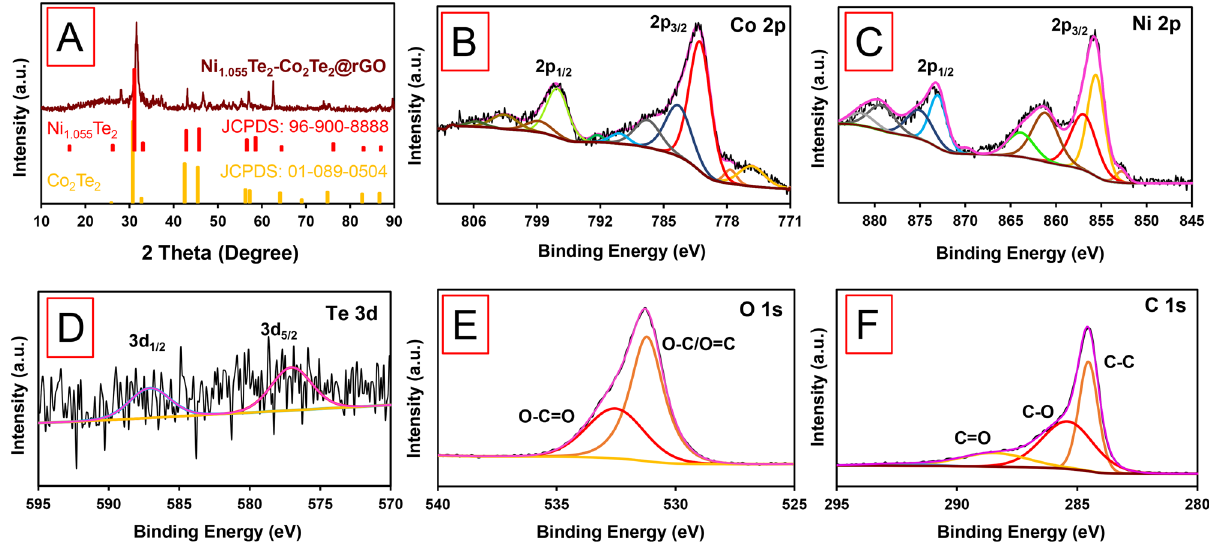
Figure 1. ( A ) XRD spectrum, and ( B – F ) High-resolution spectra of Co 2 p , Ni 2 p , Te 3 d , O 1 s , and C 1 s , respectively of